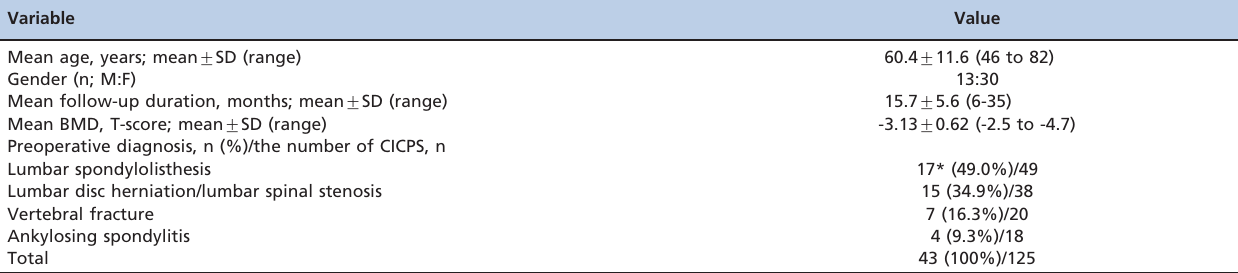
Table 1 - Baseline demographic and clinical characteristics of 43 patients with cement-augmented bone cement- injectable cannulated pedicle screws in the osteoporotic spine. Variable Value Mean age, years; mean ¡ SD